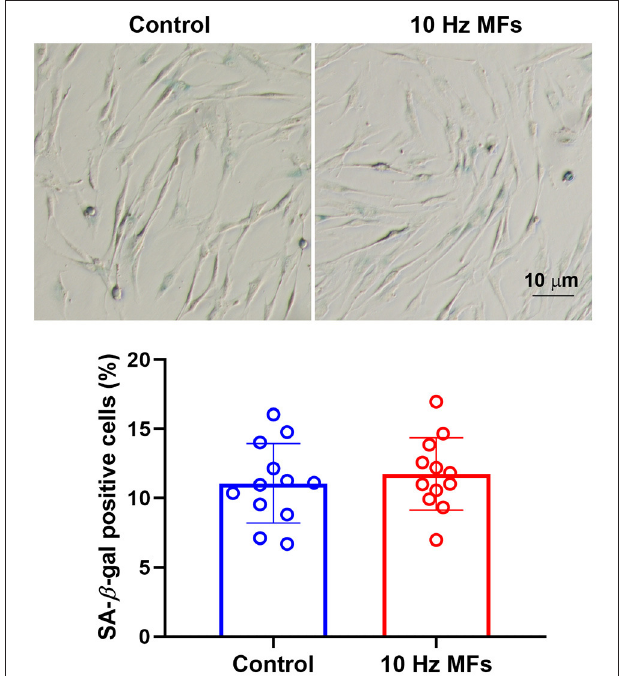
FIGURE 2 | The effect of 10Hz pulsed MFs exposure on SA- β -gal staining in 2BS cells. Representative images show the SA- β -gal staining in 2BS cells of control and 10Hz pulsed MFs exposure group, bar = 10 µ m, and the graphic shows the statistical values of SA- β -gal staining (Percentage of positive staining cells), data were presented as mean ± SD. SA- β -gal, senescence-associated β